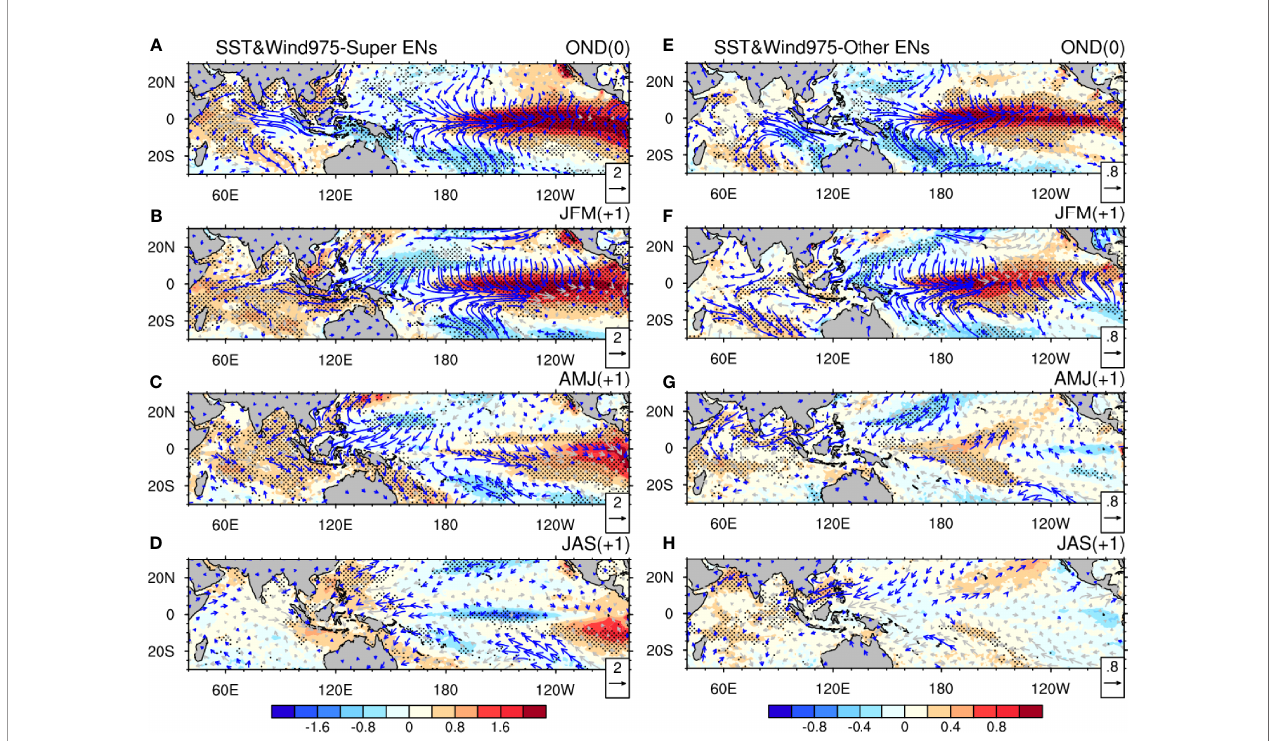
FIGURE 11 | Composited SST anomalies (shading; unit: °C) and 975-hPa wind anomalies (vector; m/s) during (A) OND(0), (B) JFM(+1), (C) AMJ(+1), and (D) JAS (+1) for super El Niño events. (E – H) Same as in (A – D) but for other El Niño events composite. The black dots and blue vectors indicate the composite exceeding the 90% signi fi cance level based on Student ’ s t -test.